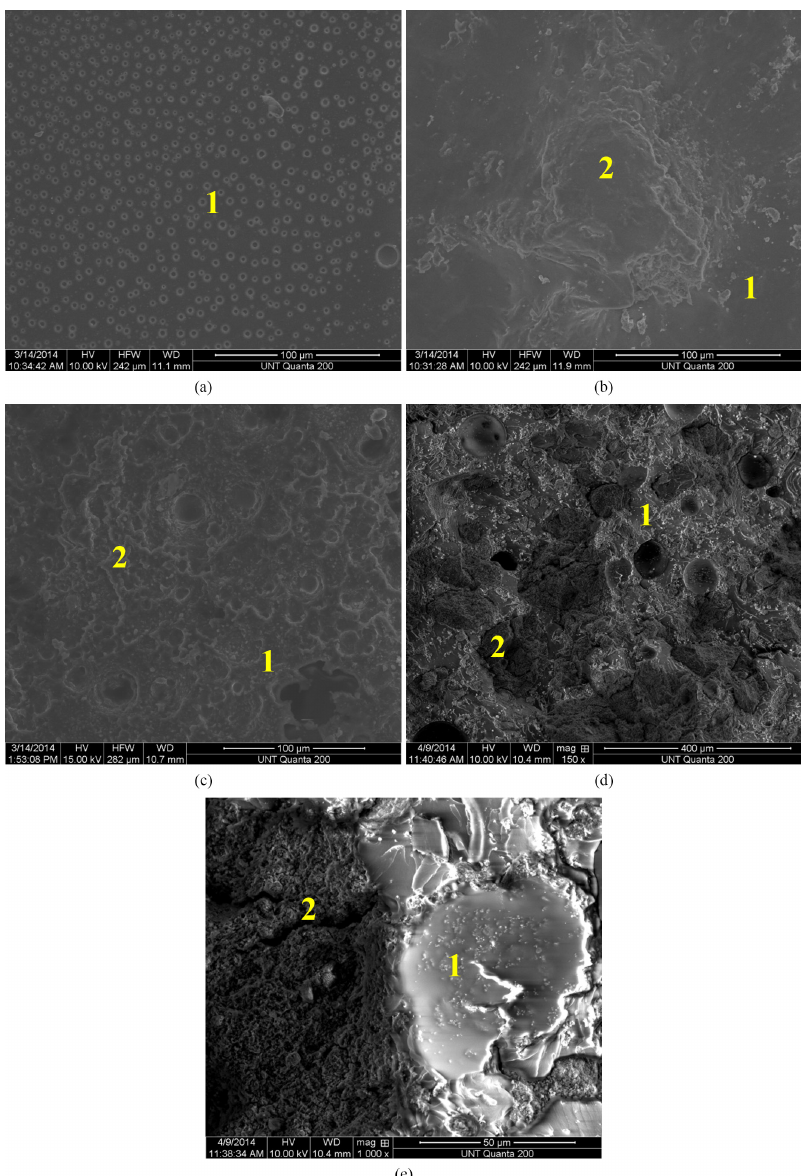
Figure 12. SEM image of PCBs ((a) 0%; (b) 17%; (c) 33%; (d) 50%; (e) 66%), (1: matrix; 2: particle).